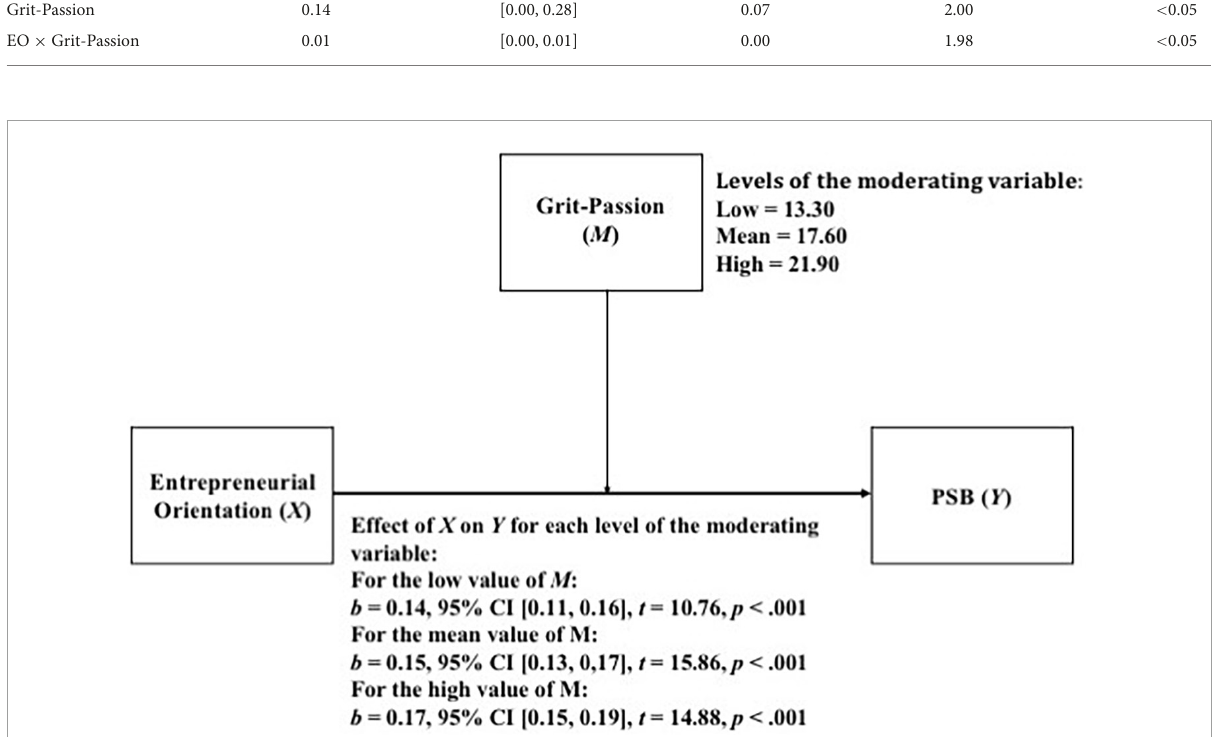
FIGURE1 Simple moderation model considering Grit-Passion as moderator.